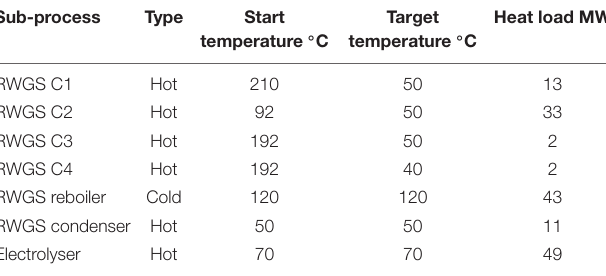
TABLE 3 | Stream table for the electrified syngas production consisting of RWGS reaction and AEC water electrolysis.